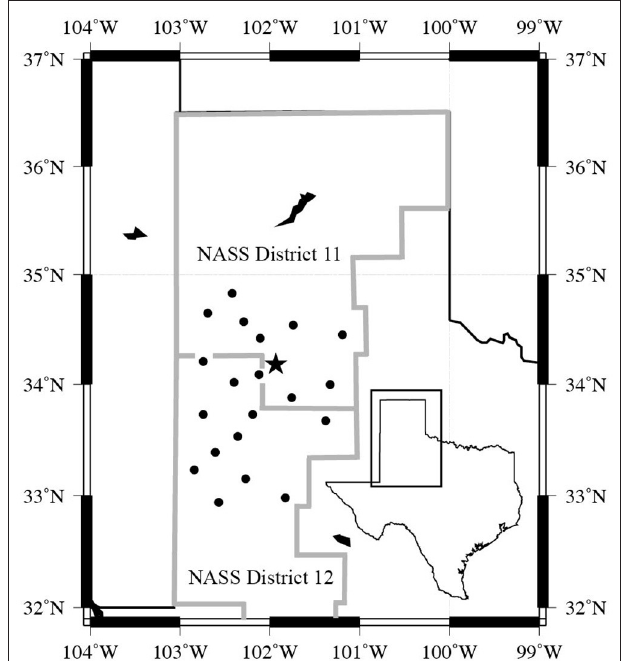
FIGURE 1 | Locations of the 21 mesonet weather stations used to provide weather input data for the CERES-Sorghum model during 2005–2016. Star marks the location of the Texas A&M AgriLife Research Center at Halfway,